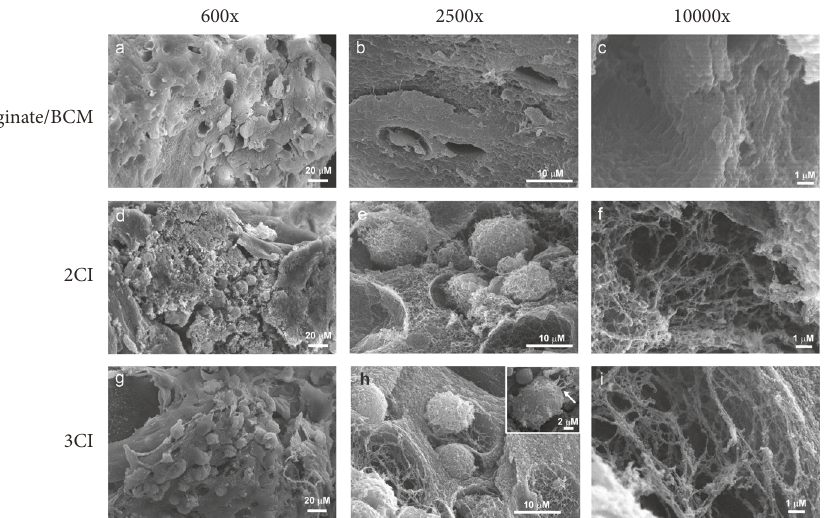
Figure 5: SEM micrographs of nontransduced (2CI) and transduced (3CI) ADSCs grown on the alginate/bovine cartilage matrix sca ff old. (a – c) Micrographs showing the ECM of decellularized bovine cartilage. (d – f) Micrographs showing the longitudinal views of the 2CI implant. (e) High magni fi cation revealed cell adhesion and chondrocyte-like morphology. (f) Matrix synthesis and fi bers around the cells after 28 days of culture. (g – i) Longitudinal views of the 3CI implant show the same characteristics as 2CI and also highlight the formation of typical isogenous groups (g and h) and fi lopodia-like structures (inset in h) after 28 days of